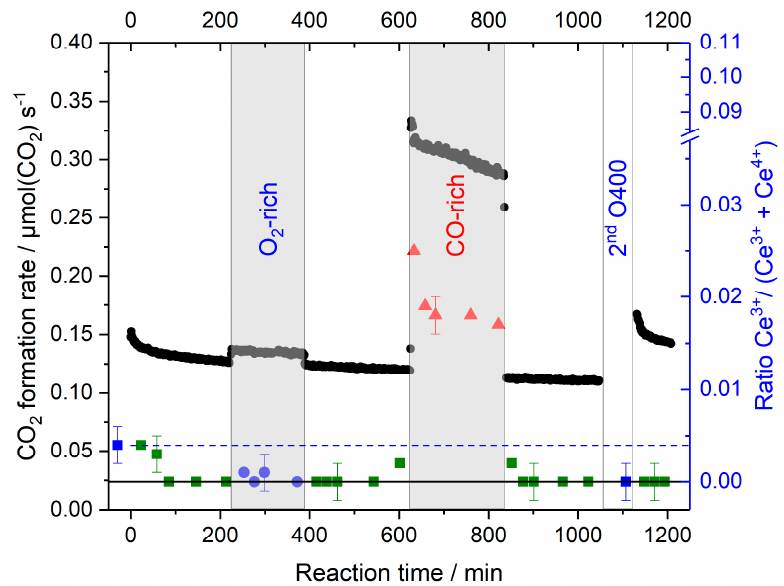
Figure 4. Formation rate during CO oxidation in di ff erent reaction atmospheres (standard, O 2 -rich, and CO-rich) at 80 ◦ C on a Au / CeO 2 catalyst after oxidative (O400) pretreatment in 10% O 2 in N 2 at 400 ◦ C (black circles) and the relative Ce 3 + content during time on stream as extracted from LCA analysis of operando X-ray absorption spectra recorded in fluorescence mode during reaction (blue, green, and red symbols). The dashed blue line denotes the initial Ce 3 + ratio (right scale). Representative error bars are shown for each sequence.